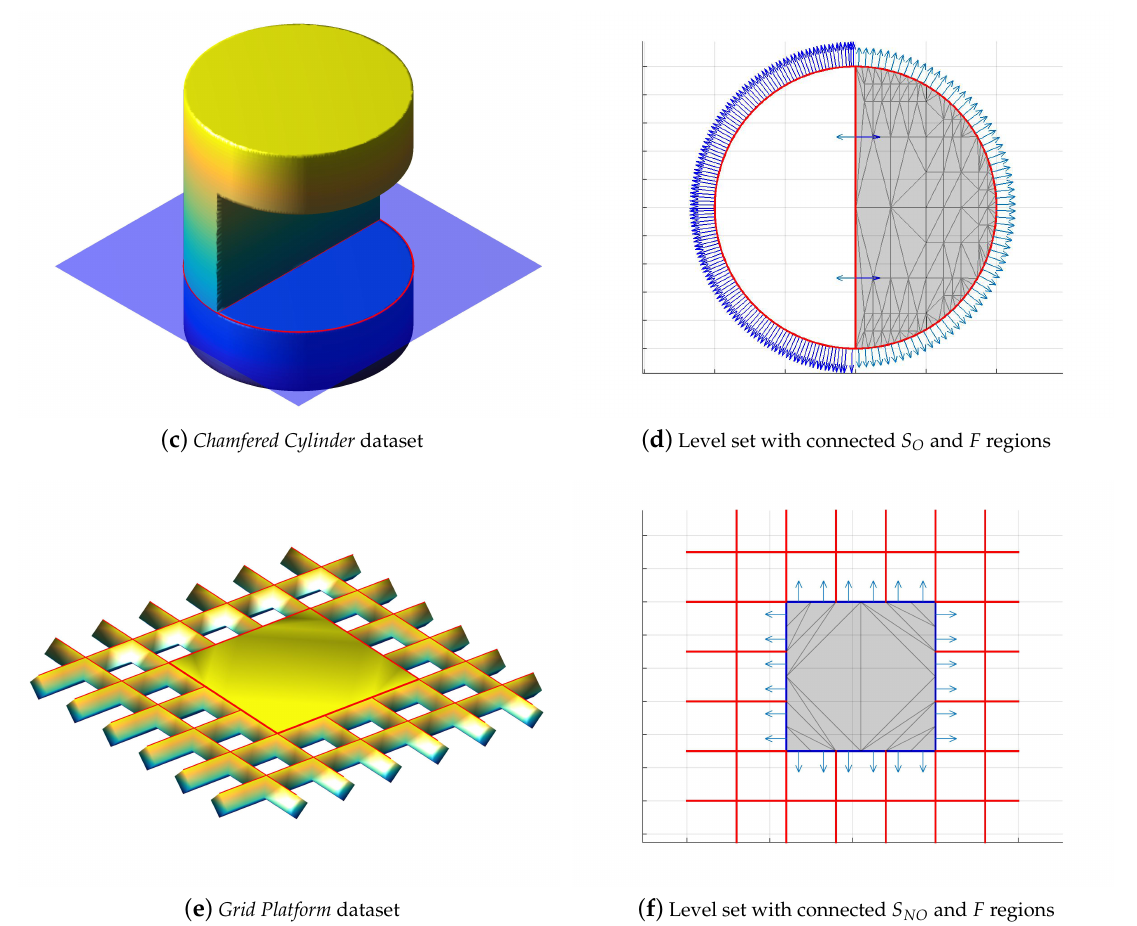
Figure 9. Level set f − 1 results for: ( a , b ), an oriented contour S O (blue) connected to a non-oriented contour S NO (red), ( c , d ) an oriented contour S O connected to a 2-manifold region F and, ( e , f ) a non-oriented S NO contour connected to a 2-manifold region F